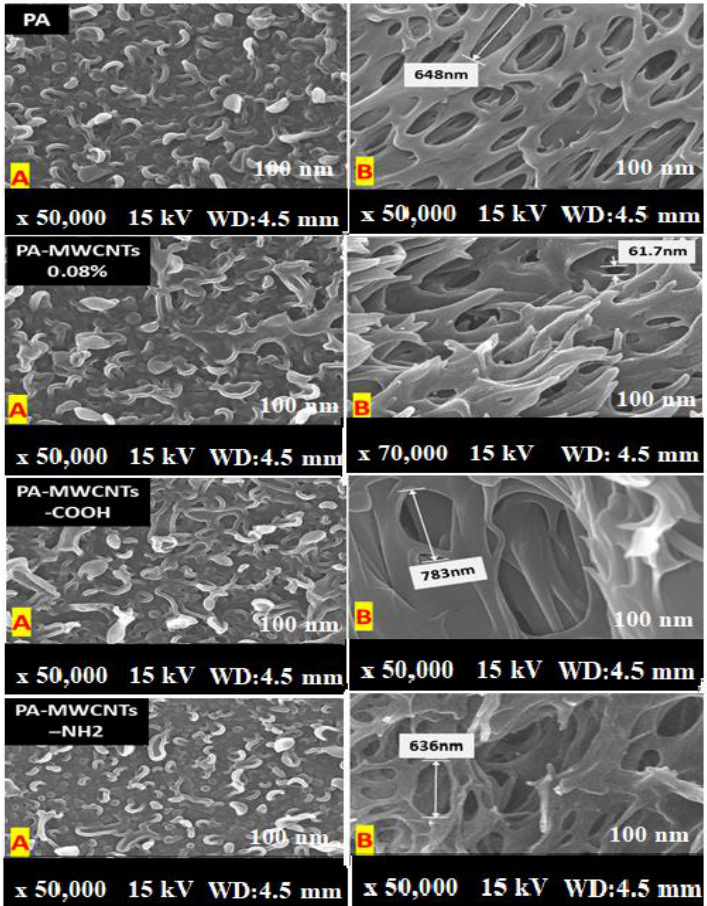
Figure 8. SEM images of the surfaces ( A ) and cross sections ( B ) of PA, PA-MWCNTs 0.08%, PA- MWCNTs 0.08%, PA-MWCNTs-COOH, and PA-MWCNTs-NH 2 MWCNTs 0.08%, PA-MWCNTs-COOH, and PA-MWCNTs-NH 2 .